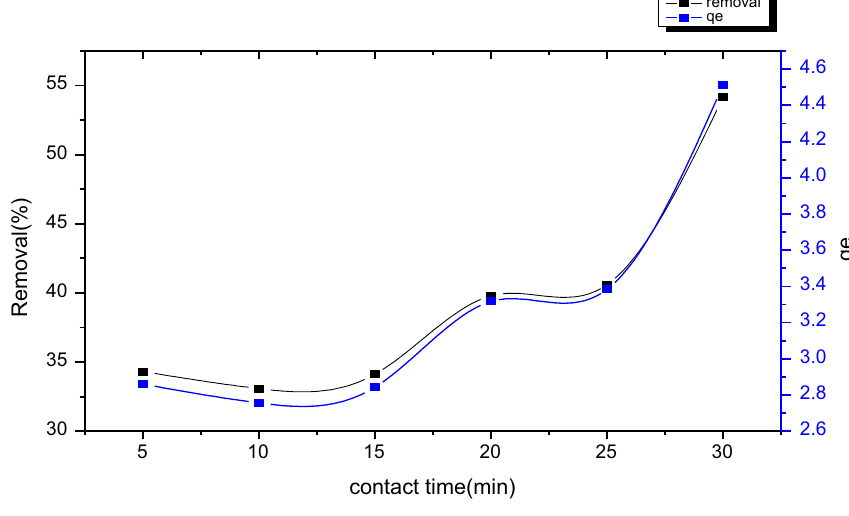
Fig. 7 Effect of contact